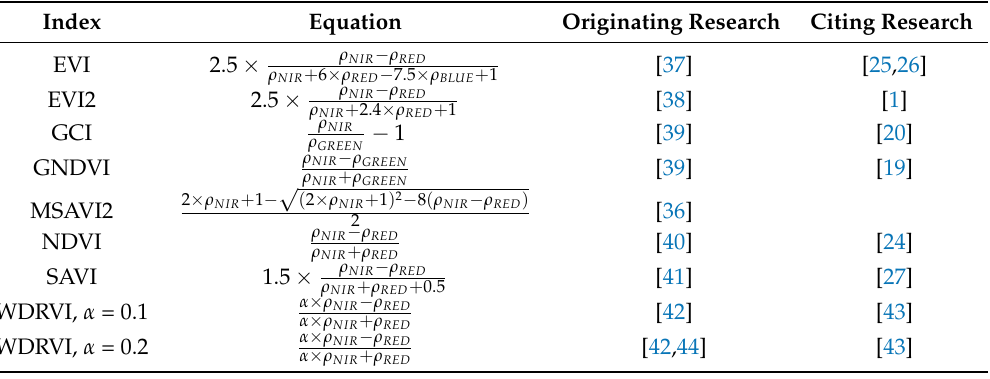
Table 1. Candidate vegetation indices, their equations, references to the papers in which they were proposed, and references to papers that use them for agricultural monitoring or related purposes. In the equations, ρ BLUE refers to reflectance in the blue wavelength band, ρ GREEN refers to reflectance in the green wavelength band, ρ RED refers to reflectance in the red wavelength band, and ρ NIR refers to reflectance in the NIR wavelength band. Non-abbreviated forms of the indices’ names can be found in the text immediately preceding the table and in the references to the indices’ originating